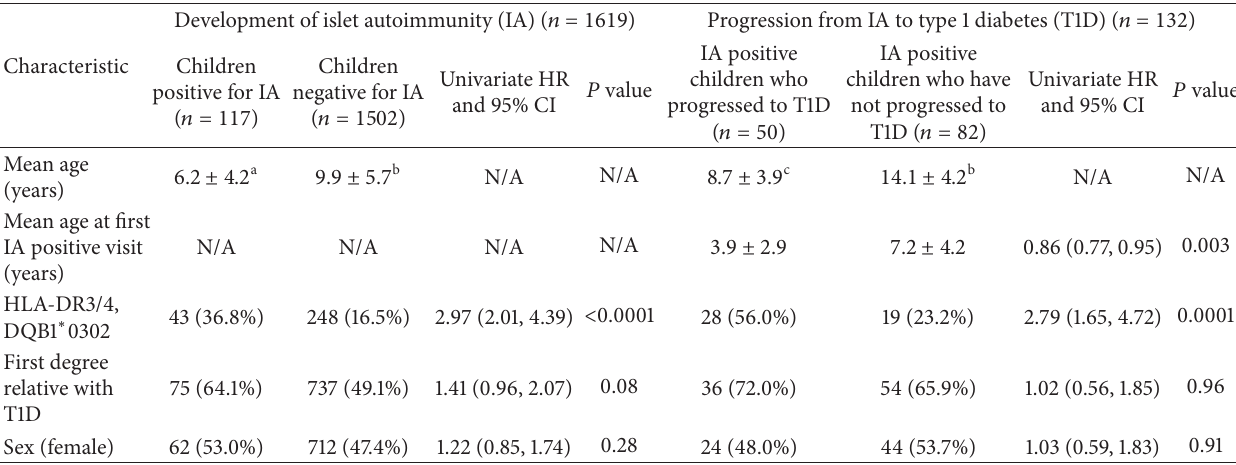
Table 1: Demographic characteristics of DAISY non-Hispanic white population.